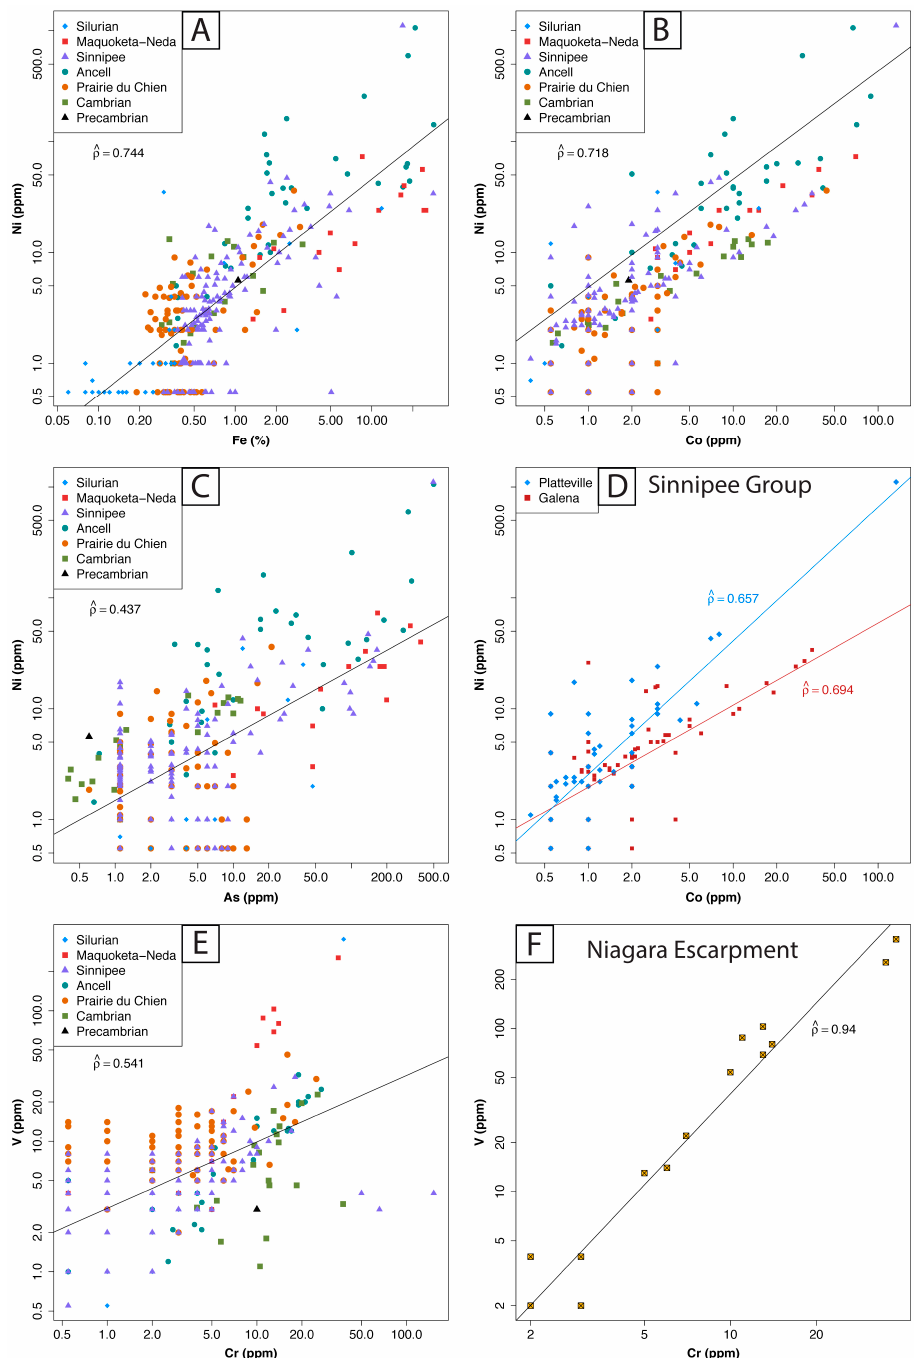
Figure 14. Scatter plots (log 10 axes) of selected metals from whole-rock ICP-AES analyses on rock specimens from northeastern Wisconsin. Legends indicate the particular stratigraphic unit sampled. ( A ) Nickel (Ni) vs. iron (Fe) for all samples, separated by stratigraphic unit; ( B ) Nickel (Ni) vs. cobalt (Co) for all samples, separated by stratigraphic unit; ( C ) Nickel (Ni) vs. arsenic (As) for all samples, separated by stratigraphic unit. Several samples exhibited elevated Ni, consistent with the presence of observed Ni-bearing minerals (see text); ( D ) Nickel (Ni) vs. cobalt (Co) for the two formations of the Sinnipee Group in northeastern Wisconsin (Platteville and Galena); ( E ) Vanadium (V) vs. chromium (Cr) for all samples in the study, separated by stratigraphic unit. Note the V-enriched samples (red squares and blue diamond in upper right area of plot) from central Brown County; ( F ) Vanadium (V) vs. chromium (Cr) for all samples from three localities along a portion of the Niagara Escarpment in central Brown